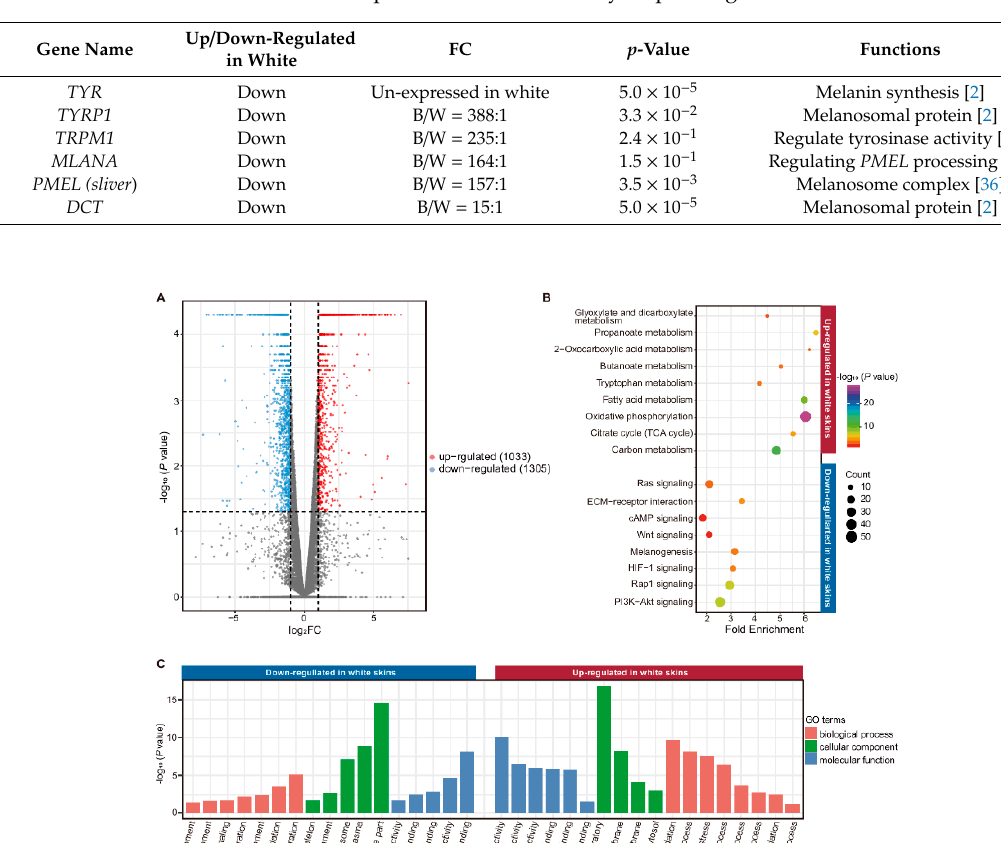
Table 1. Expression of the melanocyte-specific genes.